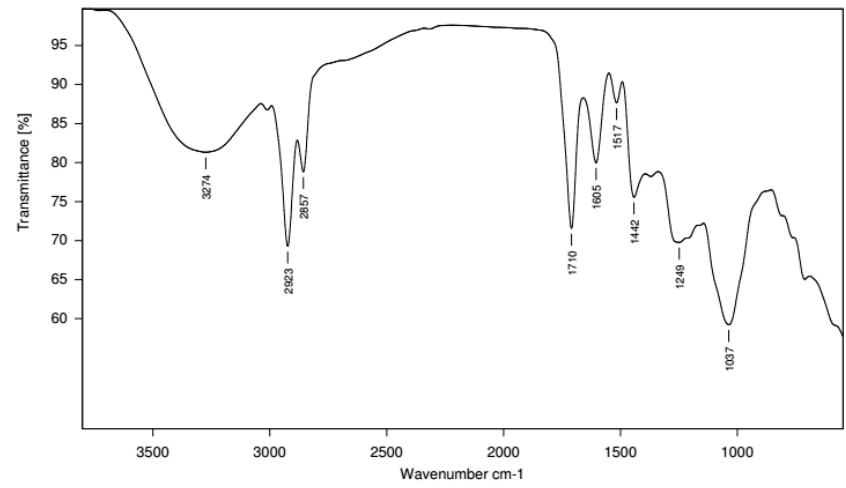
Figure 1. FTIR spectrum of methanolic fruit extract of G. latifolia.